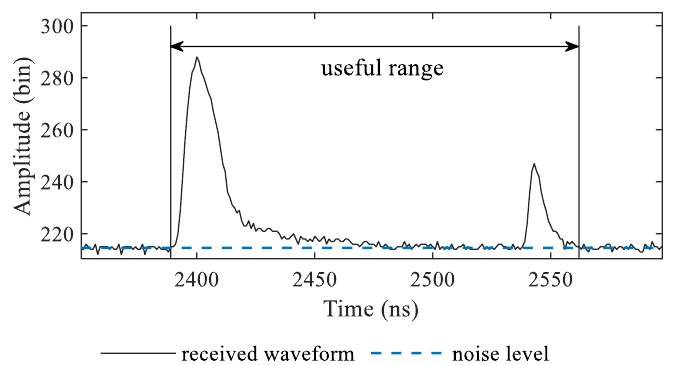
Figure 3. The useful range of the received waveform. The received waveform recorded by the ALB system ranges from 0–3200 ns, while the useful range is 2389–2562 ns.